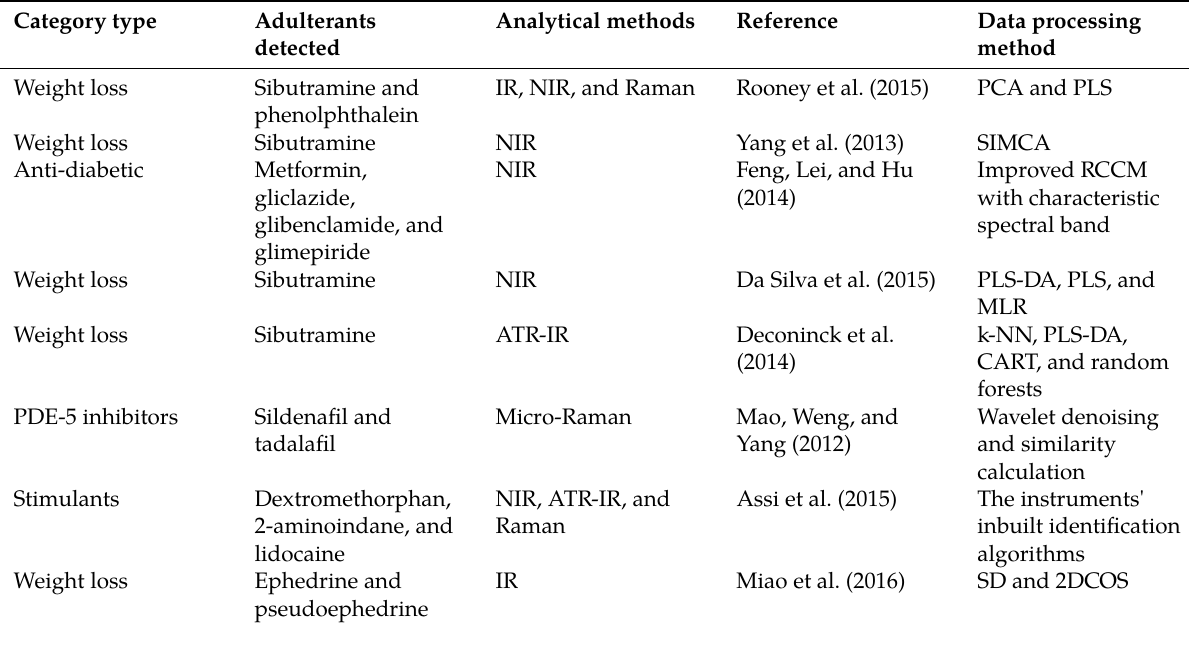
Table 1: Summary of spectroscopic methods used for analysis of adulterant pharmaceutical chemicals in botanical di- etary